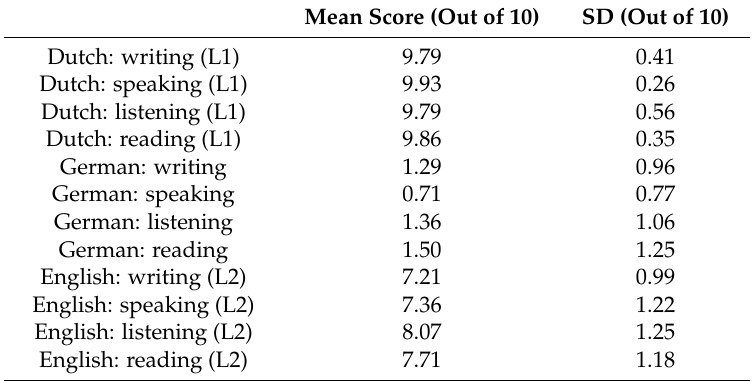
Table 3. Self-rated proficiency scores for the Dutch multilinguals without knowledge of